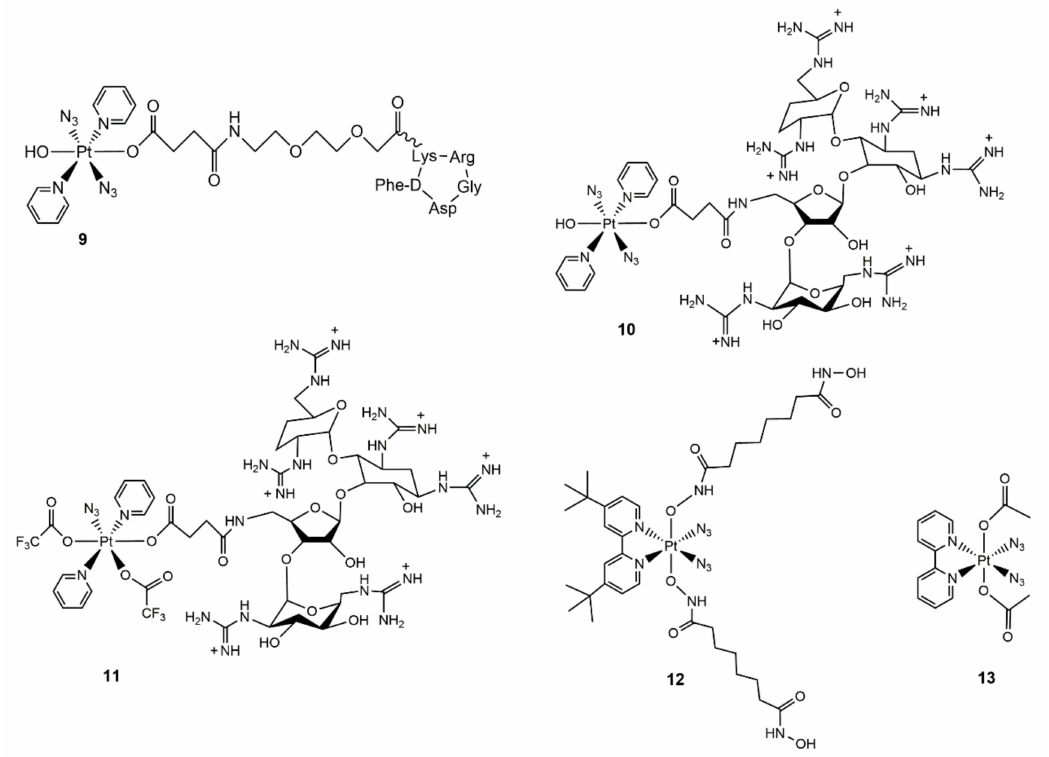
Figure 3. Chemical structures of diazido Pt(IV)